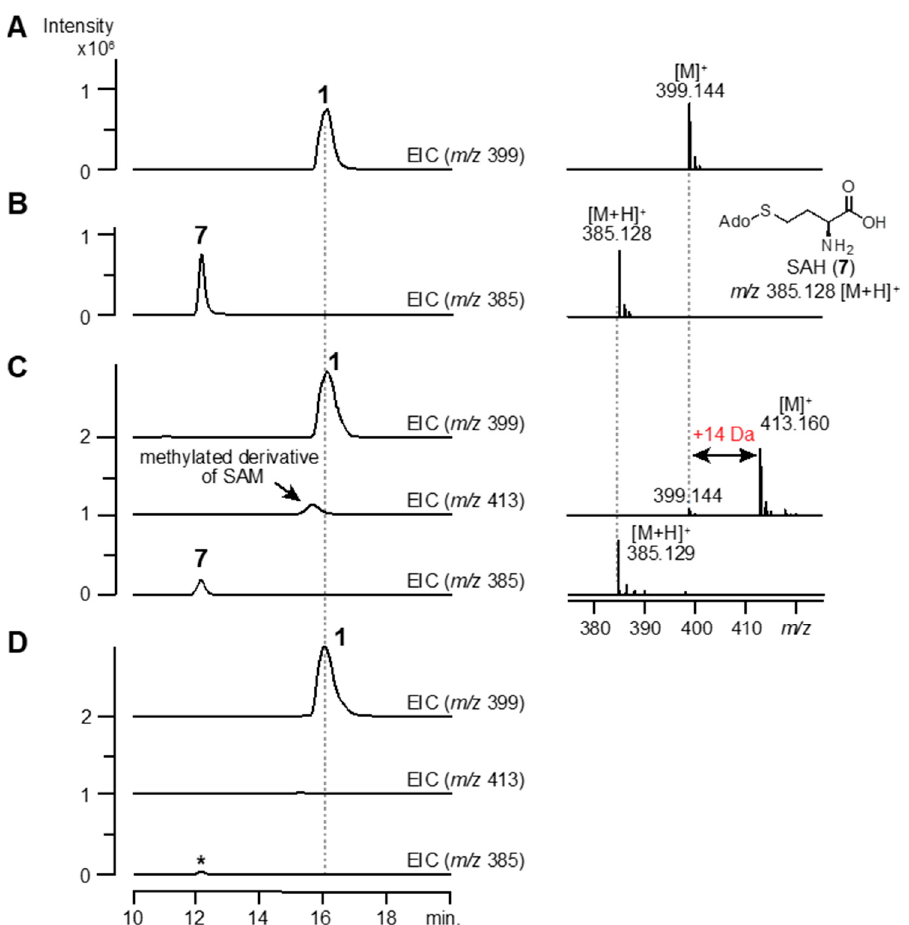
Figure 6. Enzyme reaction of rOrf29 in vitro . Standard compounds, SAM (1) ( A ) and S -adenosyl- L - homocysteine (SAH) (7) ( B ), were analyzed by HPLC-HR-ESI-MS. Compound 1 was incubated with ( C ) or without ( D ), the reconstituted rOrf29, and then the reaction mixtures were analyzed by HPLC- HR-ESI-MS. EICs for 1 ( m / z 399), 7 ( m / z 385) and the methylated derivative of SAM ( m / z 413) are shown. The asterisk denotes a spontaneously produced SAH (7).